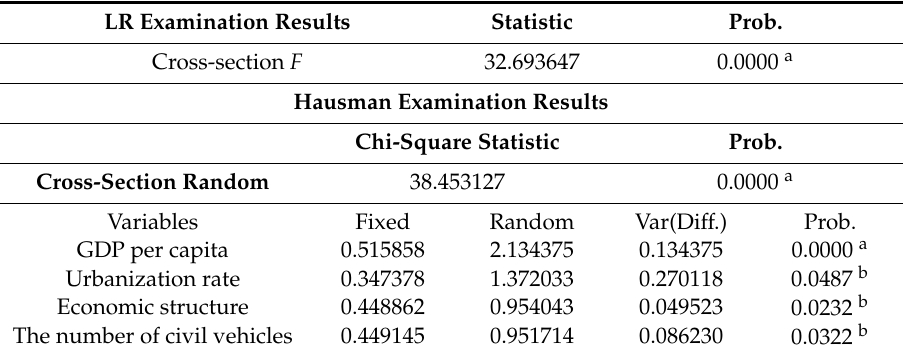
Table 6. Panel data model e ff ect identification results.